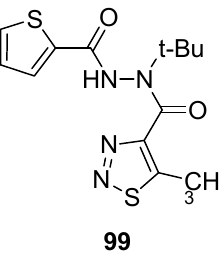
Figure 8. Antiviral 1,2,3-thiadiazole scaffold 99 . Another example of compounds with anti-TMV activity are structures 100 and 101 with a 1,3,4-oxadiazole ring (Figure 9) [109]. They showed potent curative, inactivation and protection effects against TMV. The derivative 100 displayed curative rate 54.1%, inactivation rate 90.3% and protection rate 52.8% while the compound 101 showed 47.1, 85.5 and 46.4% curative, inactivation and protection rates, respectively. The ningnanmycin was used as a standard reference drug, exhibiting a 56.1% curative rate, 92.5% inactivation rate and 59.3% protection rate. The incorporation of 1,3,4-oxadiazole moiety in the skeleton of 1,2,3-thiadiazoles significantly increased the anti-TMV activity [109].